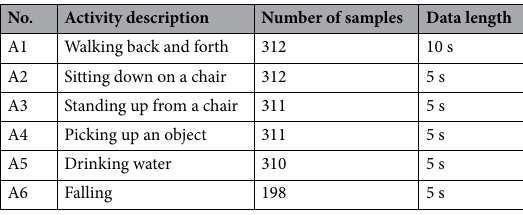
Table 1. Summary of the dataset